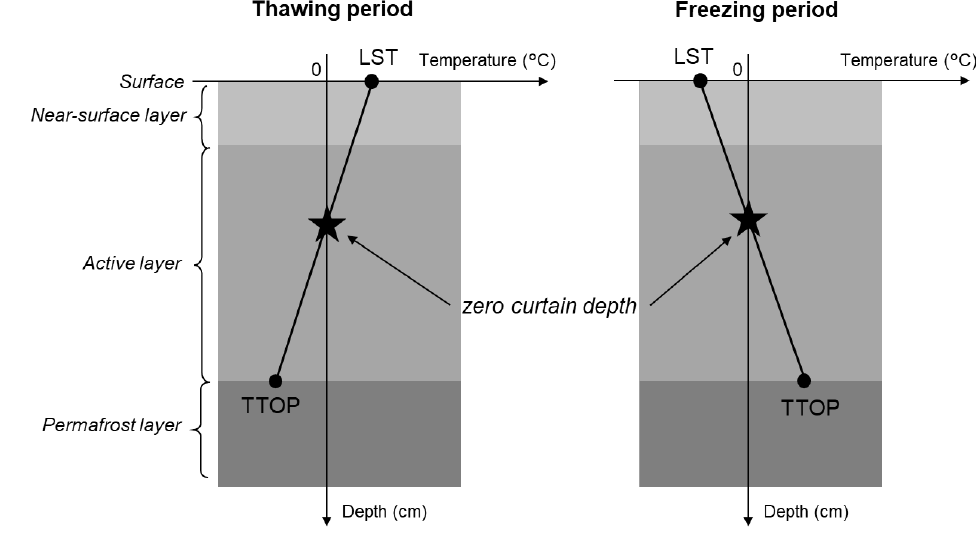
Figure 2. Conceptual diagram of TLZ